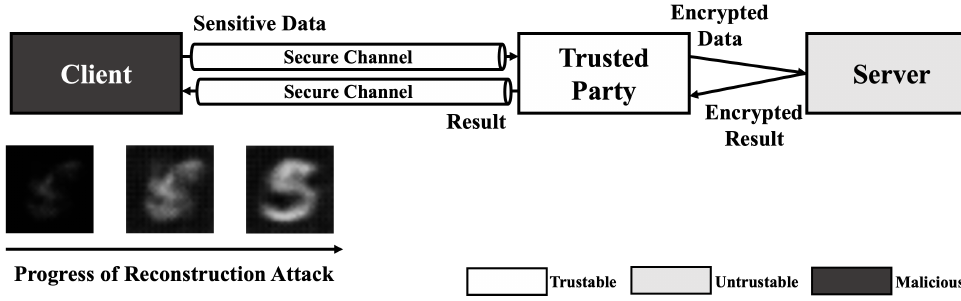
Figure 2. Reconstruction attack scenario on HE-based deep learning